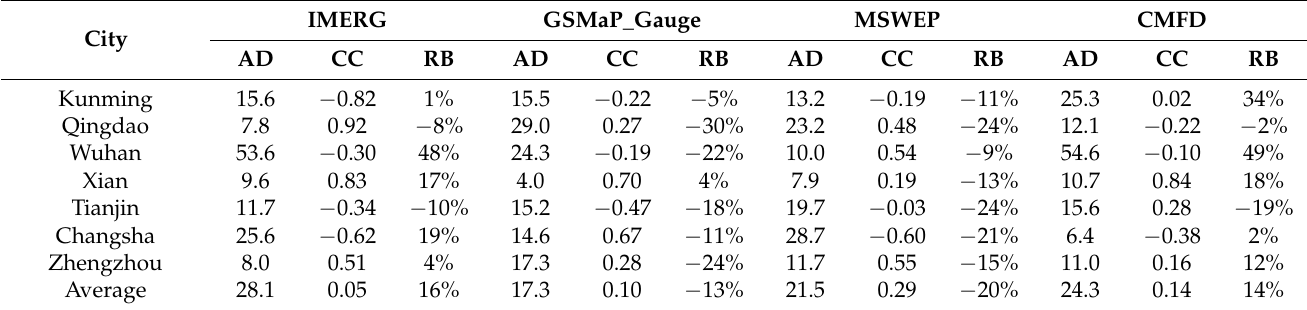
Figure 8. The absolute deviation between R99TOT values of SPPs data and rain gauges in 21 major cities: ( a ) IMERG, ( b ) GSMaP_Gauge, ( c ) MSWEP, and ( d ) CMFD. Figure 9 shows CC of R99TOT values between SPPs data and urban gauges observa- tions in 21 major cities. The results indicate that the MSWEP outperforms the other three SPPs. While the majority of cities demonstrate a positive correlation, a few cities still exhibit a significant negative correlation. The CC values for the IMERG and CMFD generally decrease from north to south, implying a stronger correlation between their R99TOT esti- mates and those obtained from gauge observations in northern cities. In contrast, the dis-tribution of negatively correlated cities in the GSMaP_Gauge is concentrated in the eastern regions.